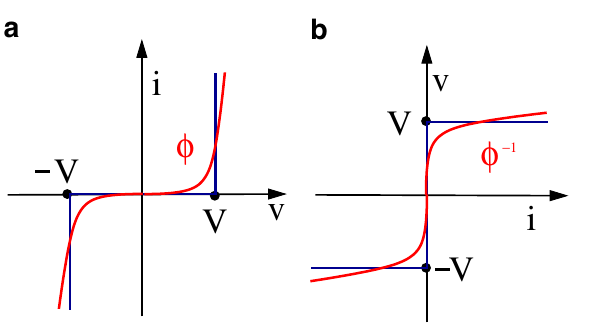
Figure 3. Nonlinear current–voltage and voltage–current characteristics. We denote by v voltage and by i current. Red: a generic threshold-like current–voltage characteristic φ , with threshold V ( a ) and its inverse φ − ( b ). Blue: the ideal, sharp threshold characteristics, which can be seen as the limit of a sequence of sharper and 1 sharper threshold-like functions φ ( a ) and φ − ( b